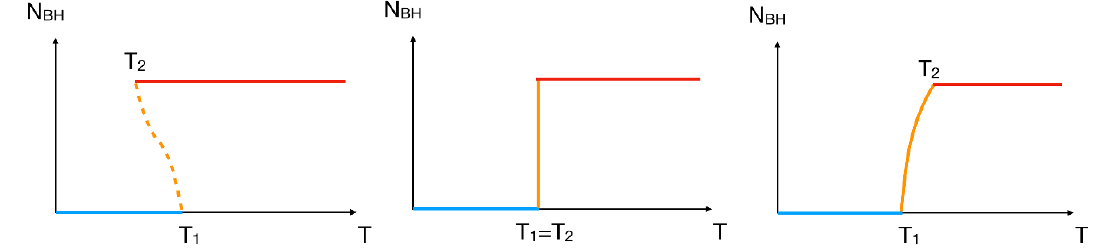
Figure 3 . Cartoon pictures of T vs N BH in gauge theory. The blue and red lines are con(cid:12)ned and completely decon(cid:12)ned phases, where N BH (cid:24) O ( N 0 ) and N BH = N , respectively. Orange lines indicate the partially decon(cid:12)ned phase.